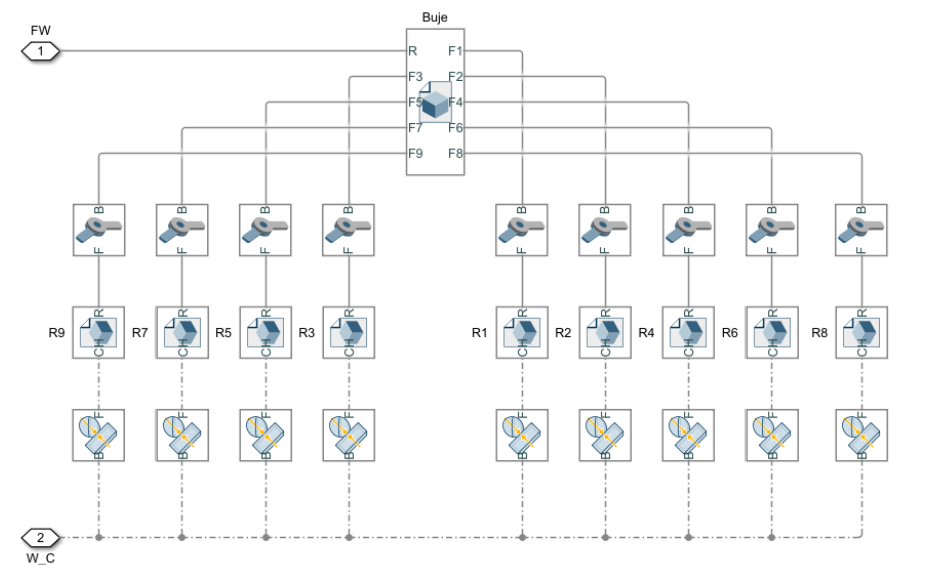
Figure 6. Internal assembly of modeled mecanum